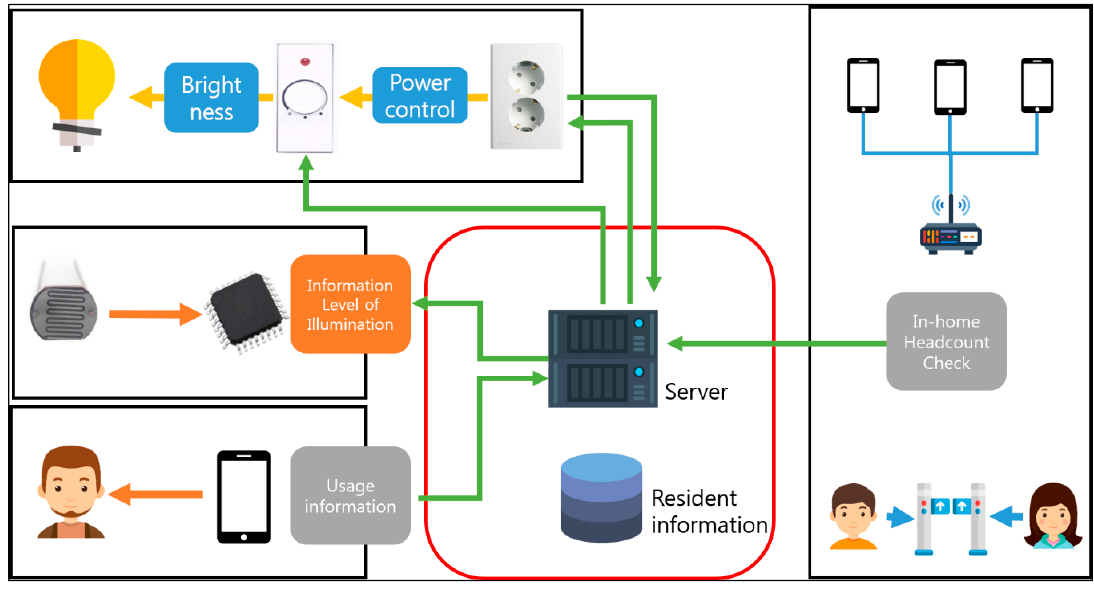
Figure 3. Functional System Diagram.